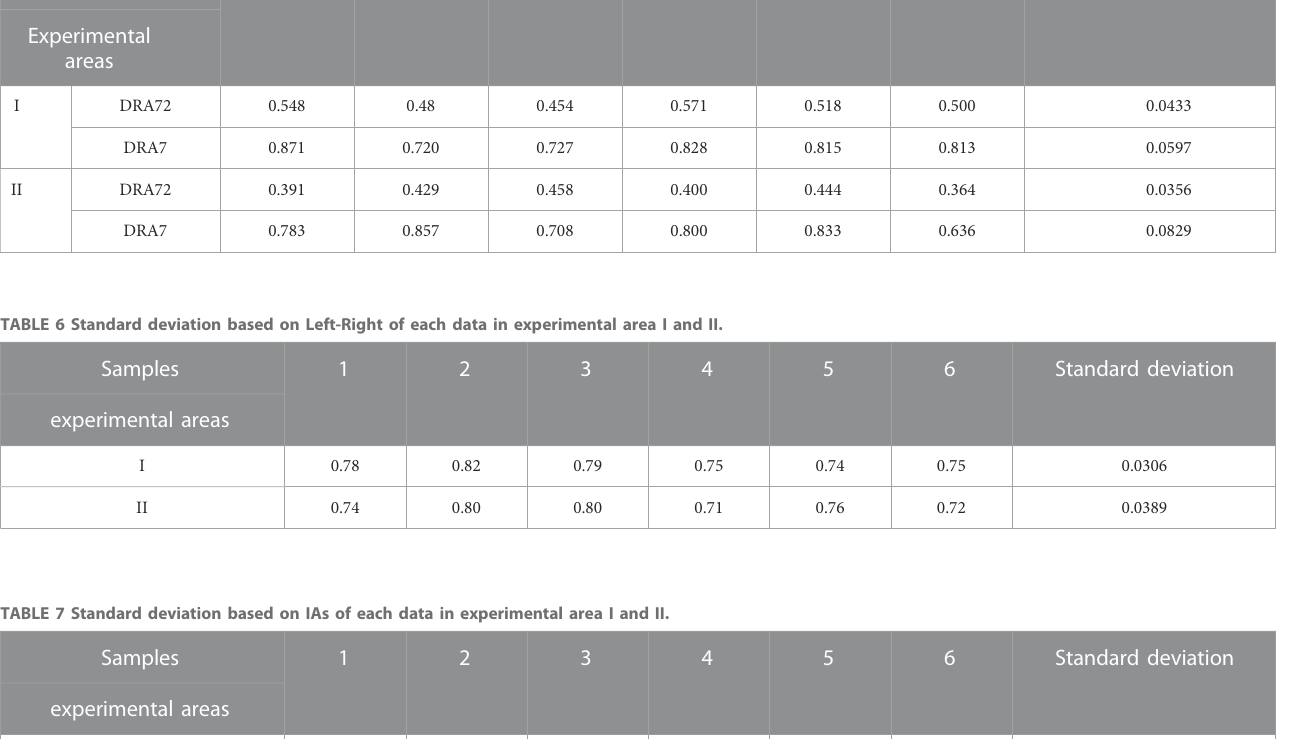
TABLE 5 Standard deviation based on DRA7&DRA72 of each data in experimental area I and II. Samples